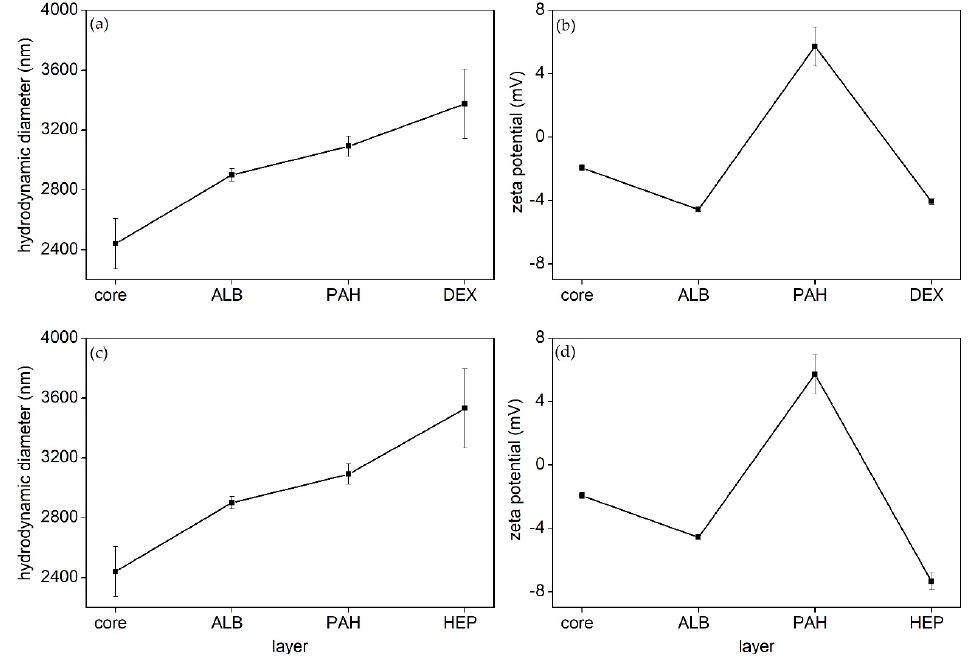
Figure 6. Hydrodynamic diameter increase ( a ), ( c ) and zeta potential changes ( b ), ( d ) during deposition of subsequent polyelectrolyte layers.